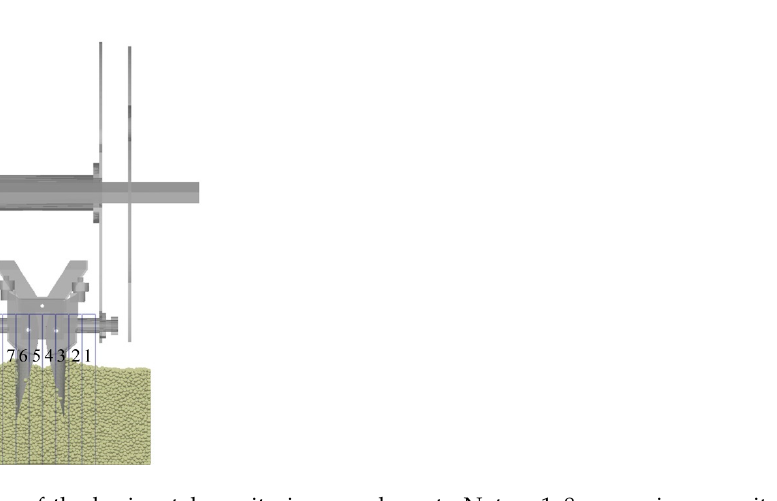
Figure 11. Diagram of the horizontal monitoring area layout. Notes: 1–8 are various monitoring zones.